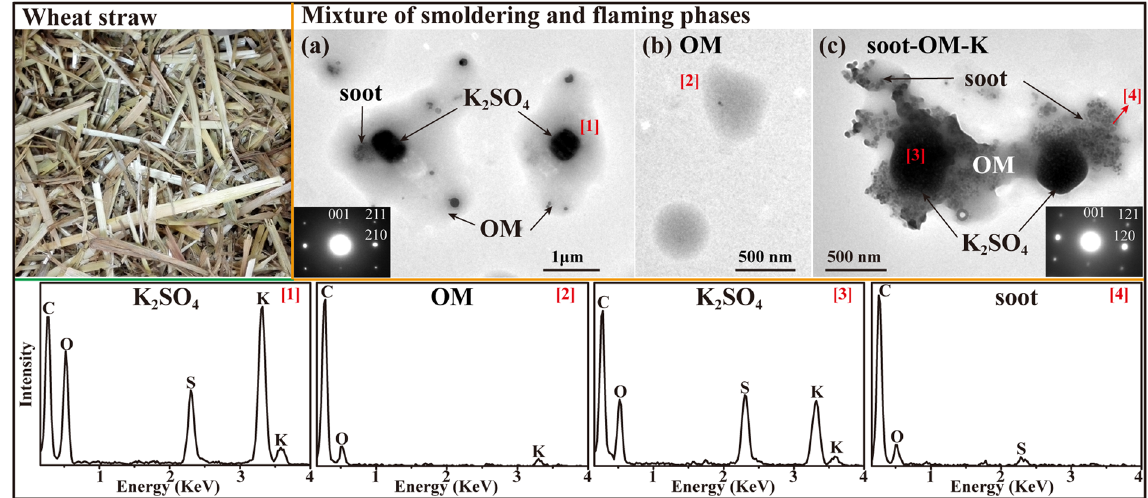
Figure 2. TEM images and EDS spectra of individual primary particles from the combustion of wheat straw. ( a ) Gel-like OM internally mixed with K 2 SO 4 /soot; ( b ) Gel-like OM without any inclusion; ( c ) One irregular particle comprised of soot, K 2 SO 4 , and OM coating. The combustion phase was a mixture of smoldering and flaming phases. The insets show the electron diffraction patterns of K 2 SO 4 with different K/S ratio. The corresponding EDS spectra are indicated by the number in square brackets.